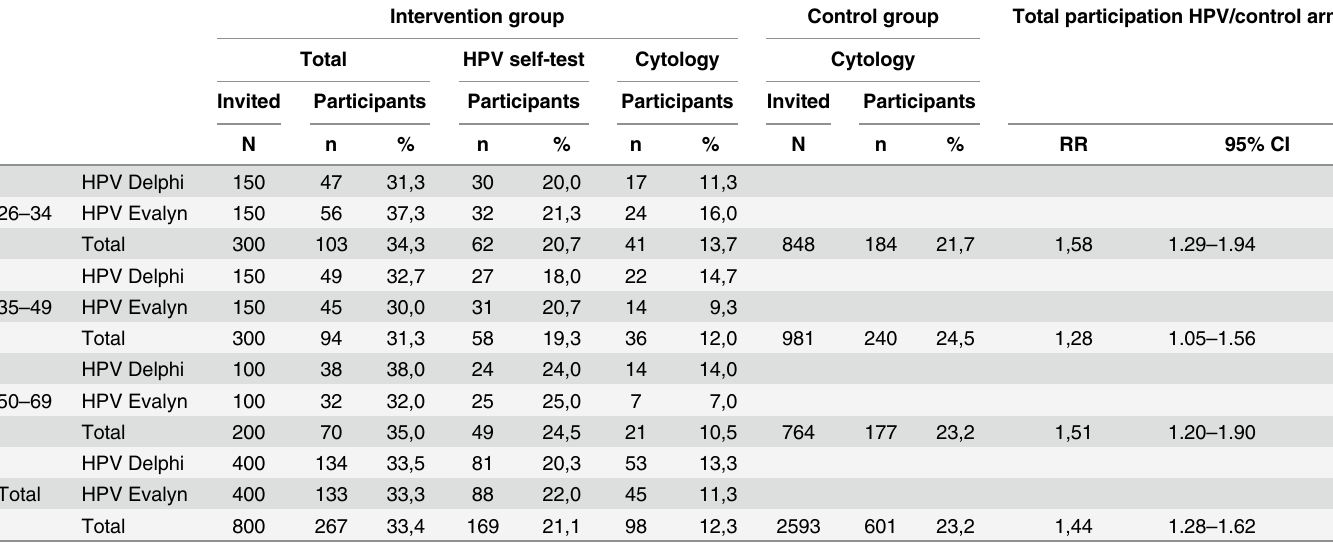
Table 1. Attendance rates in the intervention group and the control group by age and self-sampling